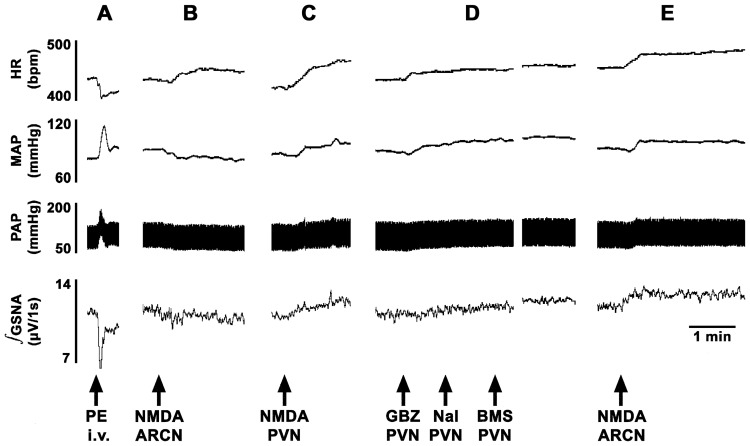
ARCN stimulation: tracing showing effect of GABA-A, NPY1 and opioid receptor blockade in the PVN.Top trace: HR (beats/min), second trace: MAP (mmHg), third trace: PAP (mmHg), bottom trace: integrated GSNA (µV/1s). A: bolus injection of PE (10 µg/kg, i.v.) elicited increase in MAP, reflex bradycardia and reflex inhibition of GSNA. B: Unilateral microinjection of NMDA (10 mM, 20 nl) into the ARCN elicited decreases in MAP and GSNA and an increase in HR. C: 20 min later, ipsilateral PVN site was identified by a microinjection of NMDA (10 mM, 30 nl); increases in MAP, HR and GSNA were elicited. D: 20 min later, gabazine (1 mM), naloxone (20 mM) and BMS193885 (15 mM) (30 nl each) were microinjected into the ipsilateral PVN; increases in MAP, HR and GSNA were elicited (a gap in the tracings was inserted to accommodate the peak response). E: After an interval of 15 min, when the MAP showed about 80% recovery, NMDA (10 mM, 20 nl) was again microinjected into the ARCN; decreases in MAP and GSNA were converted to increases in MAP and GSNA but tachycardic responses remained unchanged. BMS, BMS193885; GBZ, gabazine; GSNA, greater splanchnic nerve activity; Nal, naloxone; PAP, pulsatile arterial pressure; PE, phenylephrine.